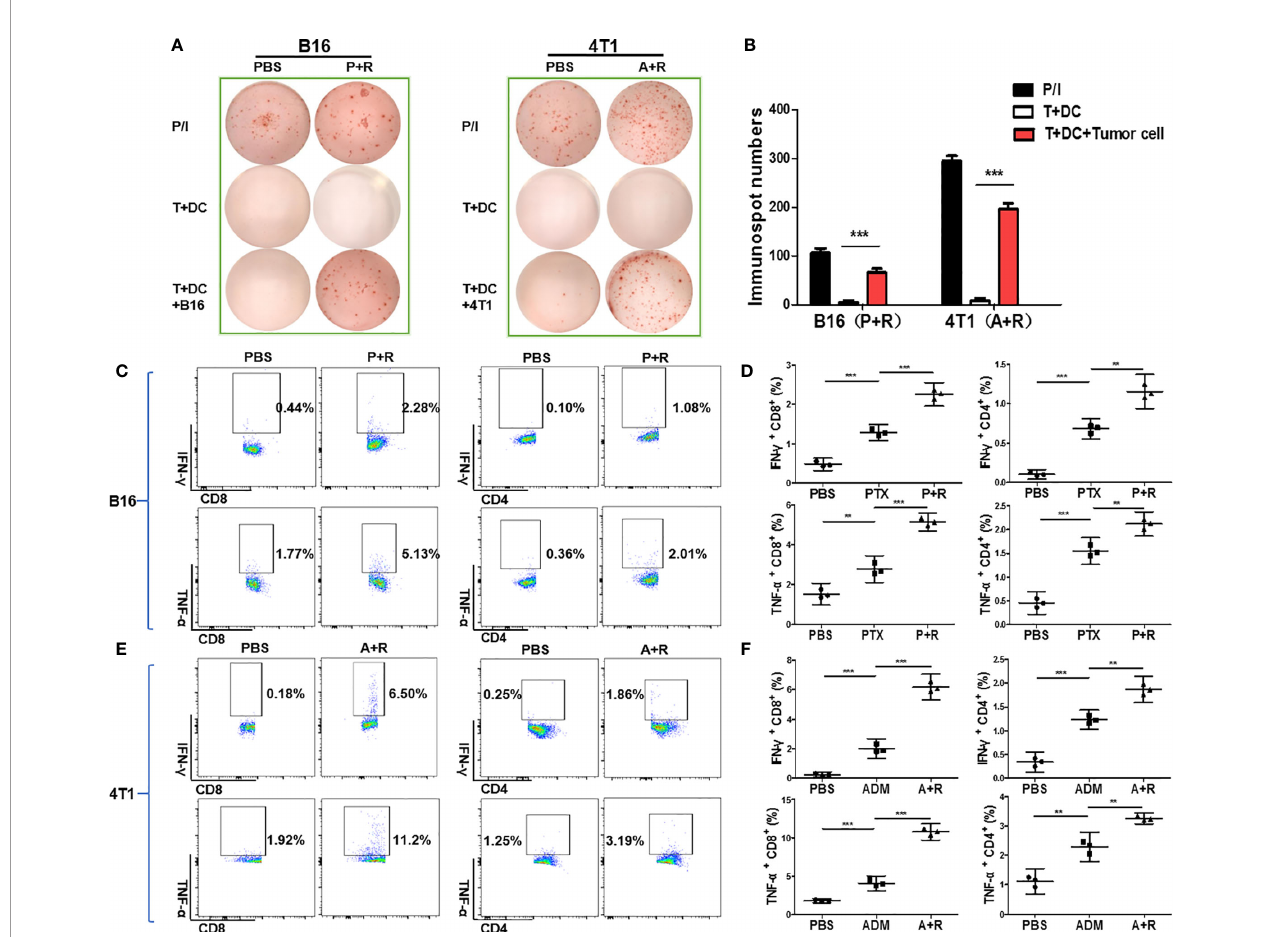
FIGURE 5 | Local CAER treatment increased the number of tumor-reactive T cells in vivo . (A) ELISpot analysis for immune responses to T cells under the different treatments (PBS, PTX/ADM, and P+R/A+R). The immune responses of splenocytes isolated from B16F10 tumor-bearing C57BL/6 mice or 4T1 tumor-bearing BABL/c mice of the different treatment groups were tested by ELISpot for the recognition of B16F10 and 4T1 tumor cells. (B) Graph of the statistical analysis of ImmunoSpot numbers. (C, E) Flow cytometric analysis of CD4/CD8 surface and intracellular cytokine (IFN- g and TNF- a ) staining to detect the activation of splenic T cells incubated with B16F10 or 4T1 tumor cells. (D, F) Graph of the statistical analysis of the fl ow cytometry results in the B16F10 and 4T1 models. P/I, PMA +ionomycin (positive control). ** P < 0.01, *** P < 0.001 by Student ’ s t